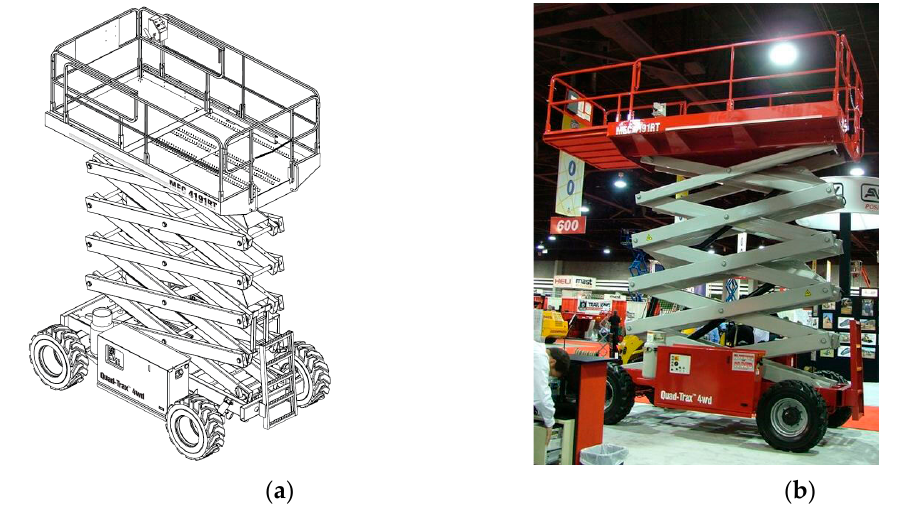
Figure 1. The scissor lift MEC 4191RT: ( a ) isometric projection [52]; ( b ) real object of investigation [53]. Table 1. Selected technical data and geometrical dimensions of the scissor lift MEC 4191RT [52].